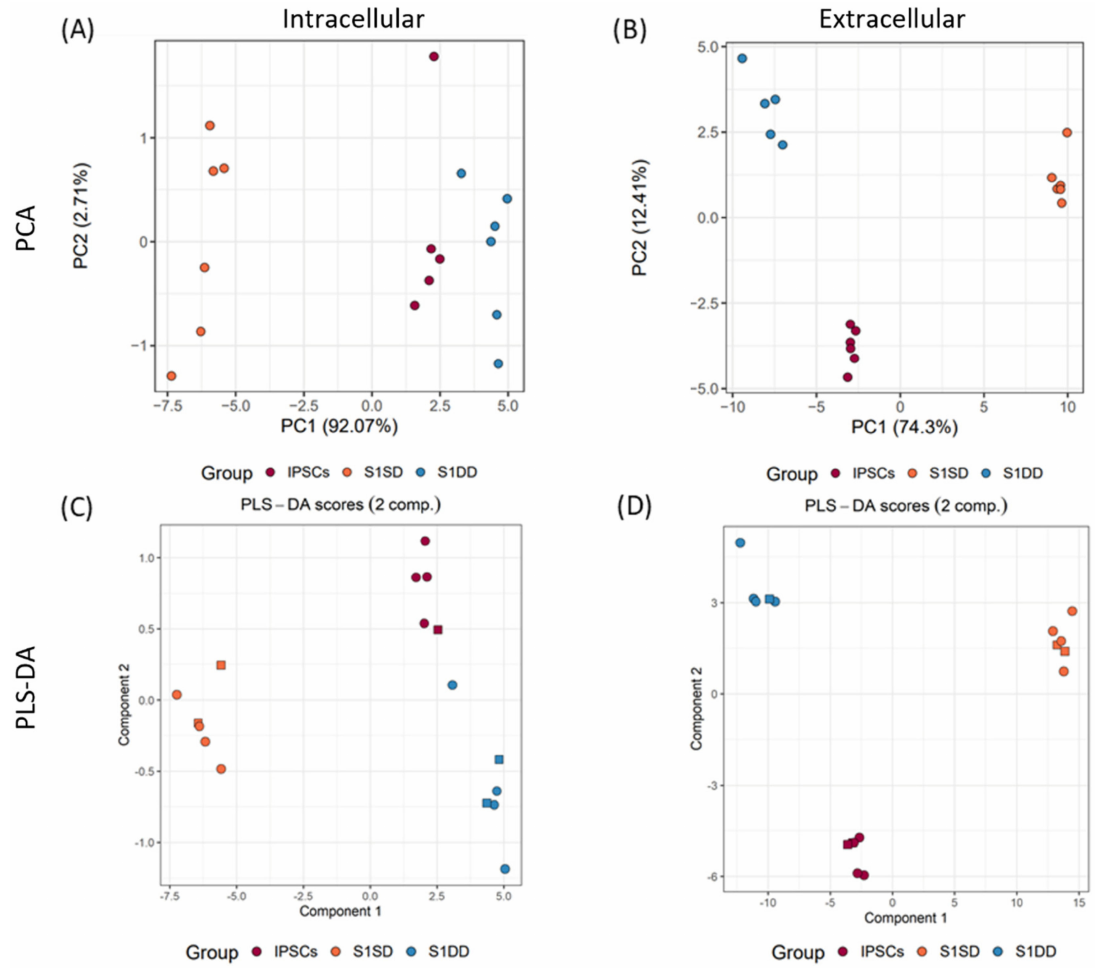
Figure 1. Comparisons of pluripotent and differentiating cell cultures of IPSC, directed differentiation (DD) or embryoid bodies (EB) with DD and EB 4-day post-differentiations by metabolomics. ( A , B ) Un- supervised PCA plots of ( A ) intracellular and ( B ) extracellular components. ( C , D ) Discriminant two-component PLS-DA plots of ( C ) intracellular and ( D ) extracellular with cross-validated ROCs, each scoring 1. Media sample data adjusted for cell-free controls. Circles or squares indicate the split of data between training and testing, respectively, for predictive PLS-DA